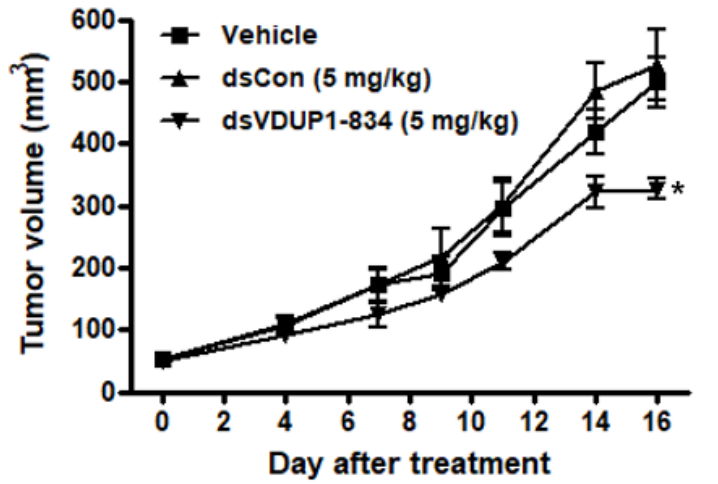
Figure 6. Inhibition of A549 tumor growth by dsVDUP1-834 treatment in nude mouse xenograft model. Specific pathogen-free BALB/c nude mice ( n = 5) were implanted subcutaneously with A549 cells (9 × 10 6 cells/mouse) and treated with vehicle, dsCon (5 mg/kg) and dsVDUP1-834 (5 mg/kg). Tumor volumes are measured, and data are represented as mean ± S.D ( n = 5). * denotes that the response is significantly different from vehicle-treated group as determined by Dunnett’s t -test at p < 0.05.